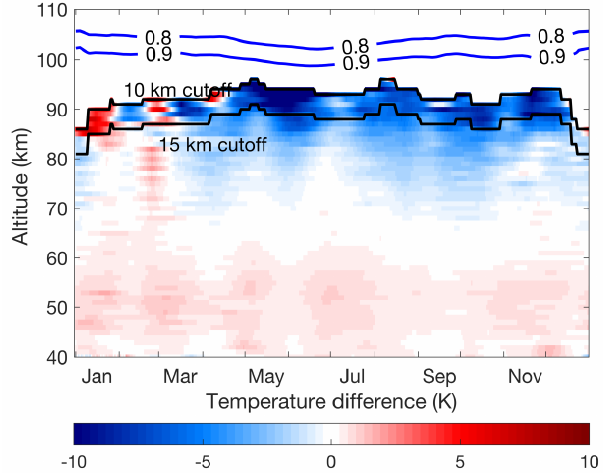
Figure 11. PCL temperature climatology difference using the OEM and HC method (OEM minus HC) using seed temperature. The blue lines show the height below which the OEM temperature climatol- ogy is more than 90% (0.9) and 80% (0.8) due to the measure- ments. The black lines are the 10 and 15km cutoff height for the HC method.